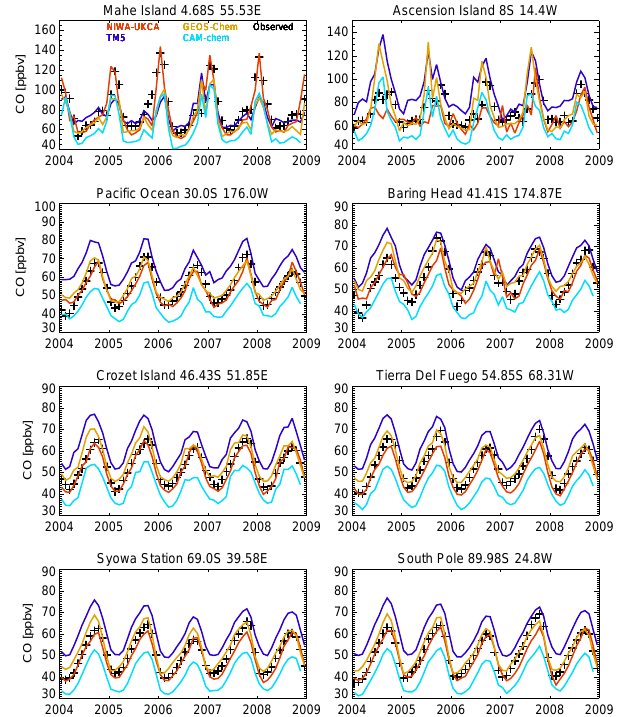
Figure 7. Modelled monthly mean surface CO with CLM- MEGANv2.1 emissions (coloured lines) and observed monthly mean surface CO at SH sites. Observations are from the NOAA GMD network (Novelli et al., 1998): http://www.esrl.noaa.gov/